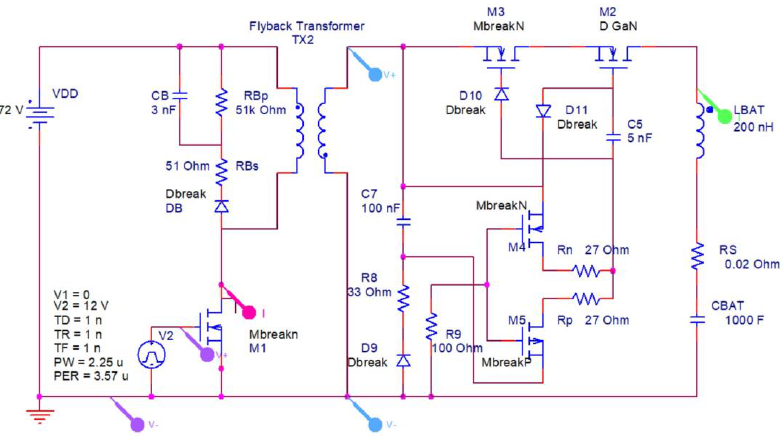
Figure 8. SPICE Figure 8. SPICE Simulation.